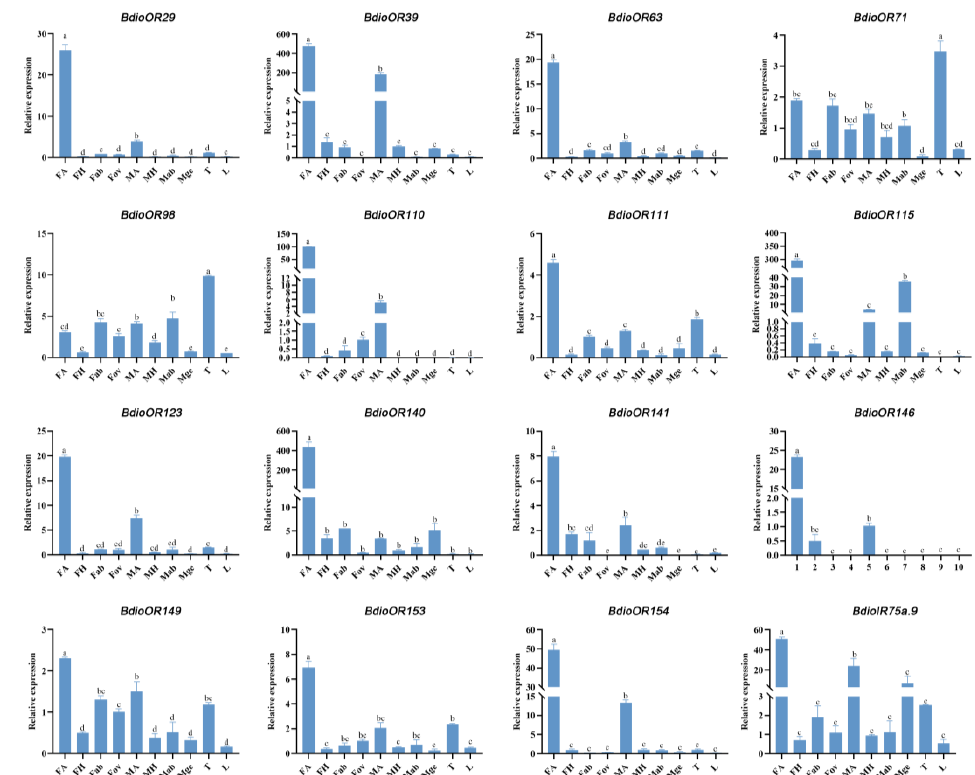
Figure 11. Expression levels of 32 candidate chemosensory genes in different tissues. (FA and MA: female and male antennae; FH and MH: female and male heads without antennae; Fab: female abdomens without ovipositors and digestive tracts, Fov: female ovipositors; Mge: male genitalia; Mab: male abdomens without genitalia and digestive tracts; T: male and female thoraxes; L: male and female legs). Columns labeled with different letters are significantly different ( p < 0.05). Table 4. Twenty-eight chemosensory genes with female antennae- and ovipositor-biased expression. Chemosensory Genes with Female Antennae-Biased Gene Family